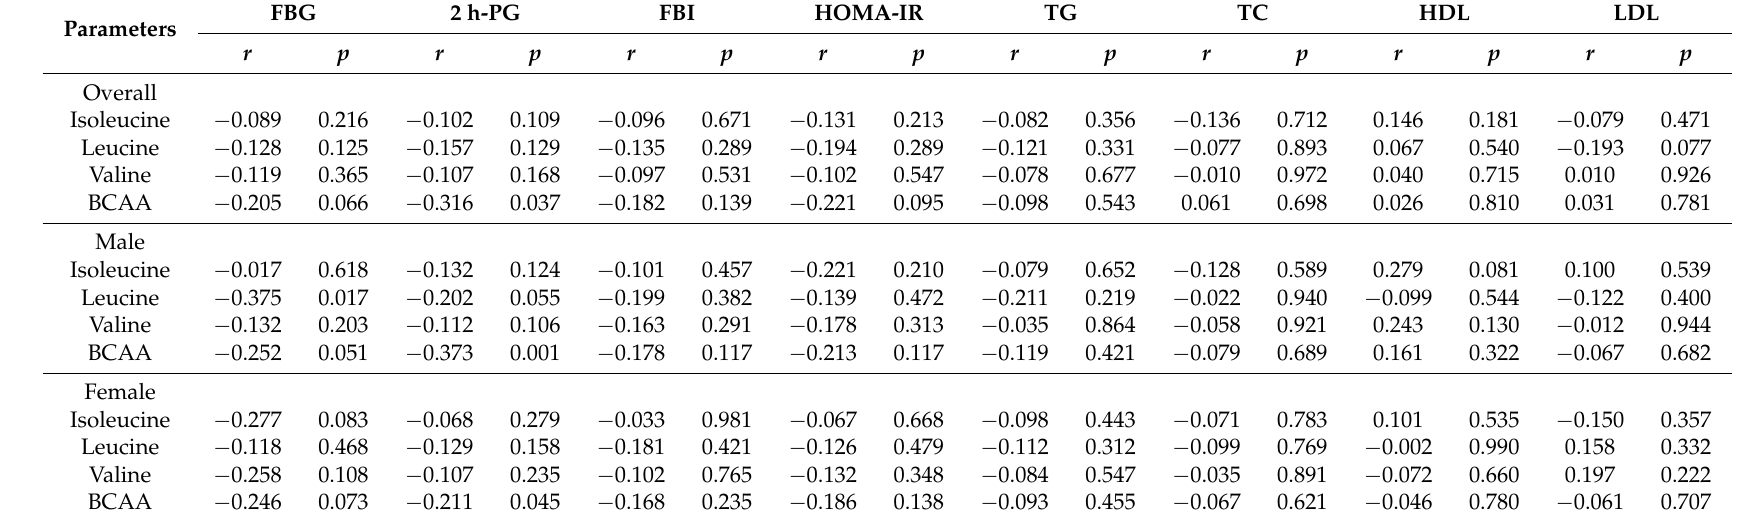
Table 4. Partial correlation analysis of ratio of BCAAs, isoleucine, leucine, and valine and metabolic